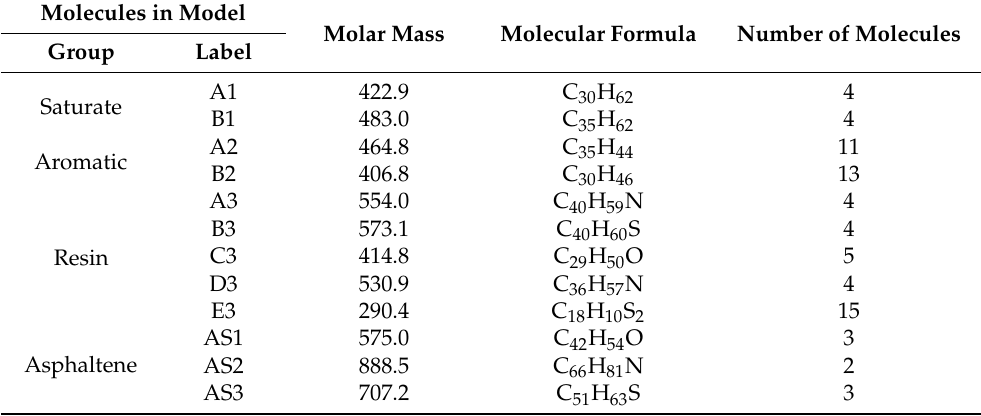
Table 1. Matrix asphalt model